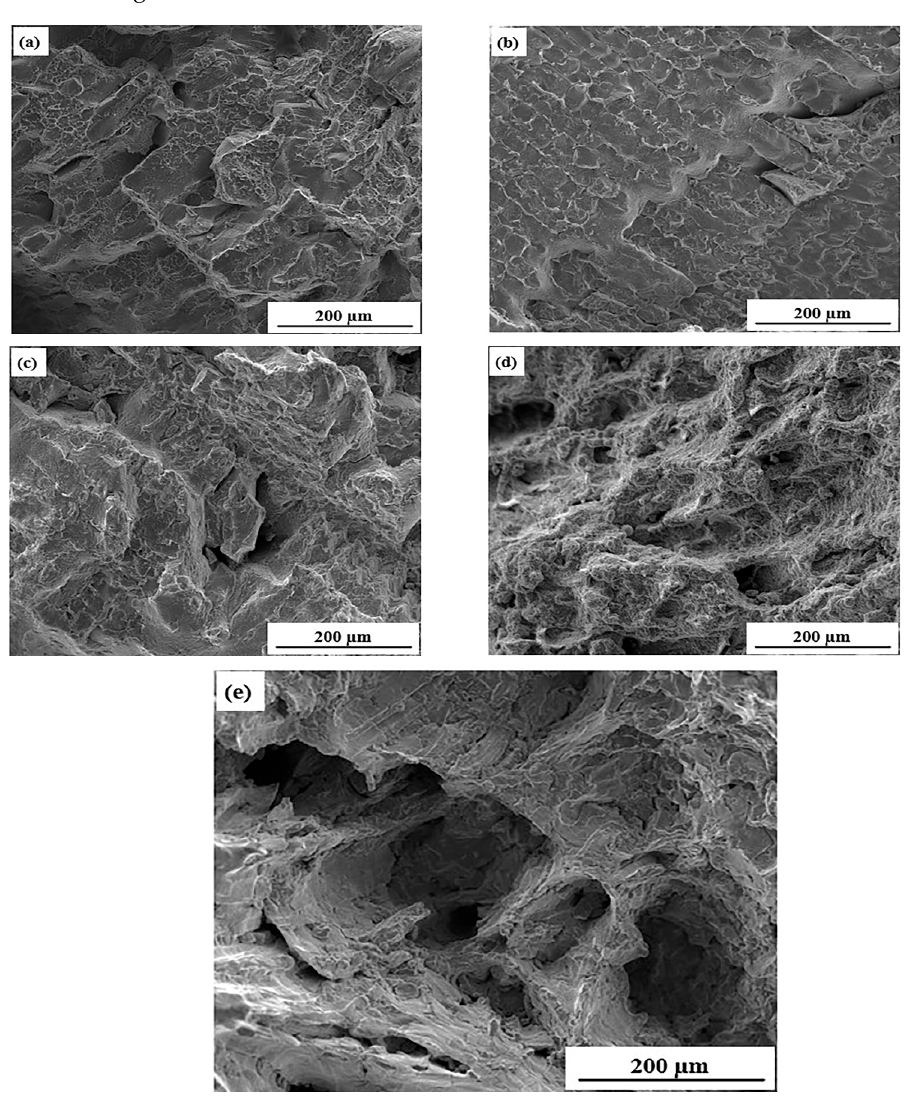
Figure 5. Fracture morphologies test sample at 500 times magnification: ( a ) 700 °C, ( b ) 800 °C, ( c ) 900 °C, ( d ) 1000 °C, ( e ) 1100 °C.